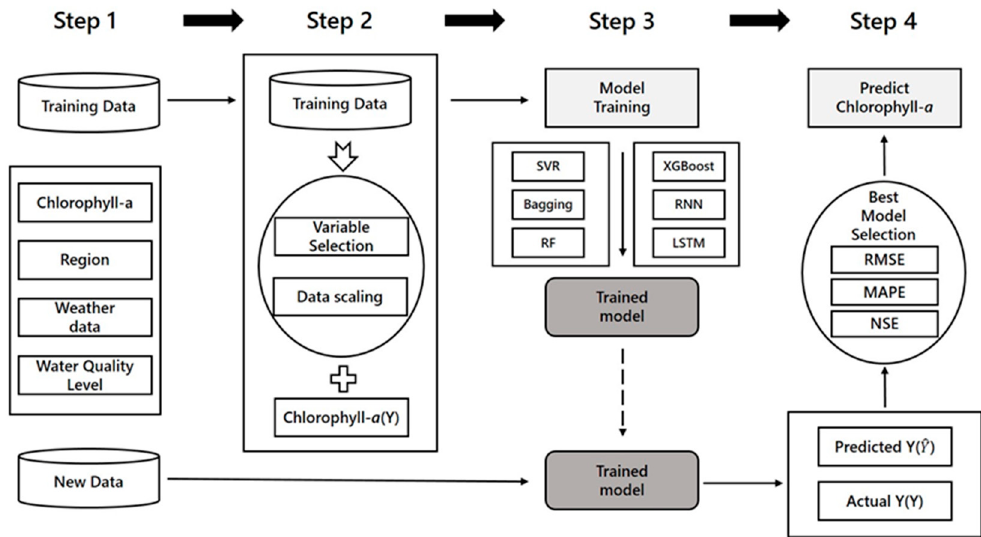
Figure 8. Flow chart of the four–step process used to find the optimal chlorophyll- a concentration prediction model.